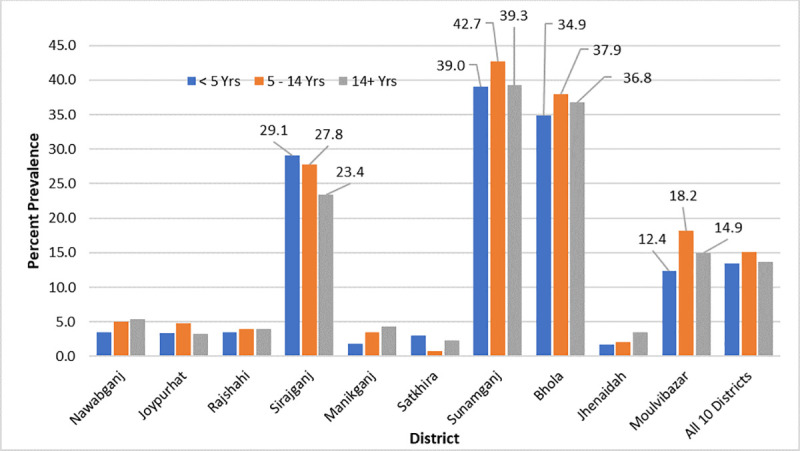
Prevalence of any STH infection by district and age group.